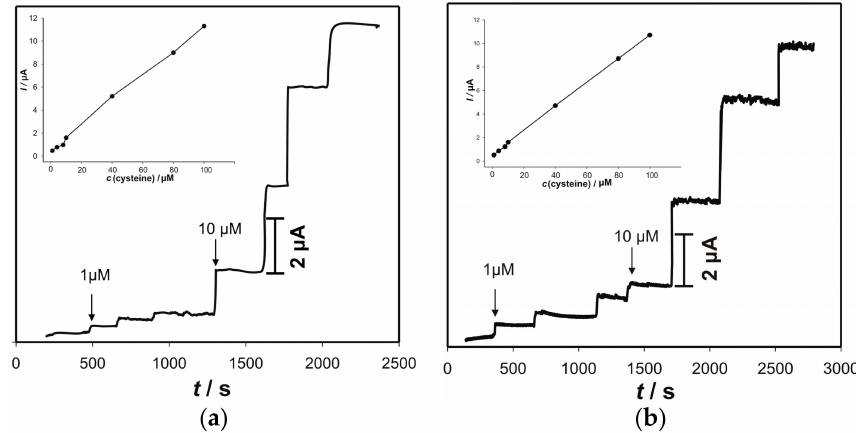
Figure 7. Amperometric responses of the electrode “ACS” on successive addition of cysteine. Measurements were performed in: ( a ) in 90 mL 0.1 KNO 3 + 10 mL 0.1 M acetate buffer pH 5 at the 0.142 V; ( b ) in 90 mL 0.1 KNO 3 + 10 mL 0.1 M phosphate buffer pH 7 at the 0.04 V. Insets show corresponding calibration